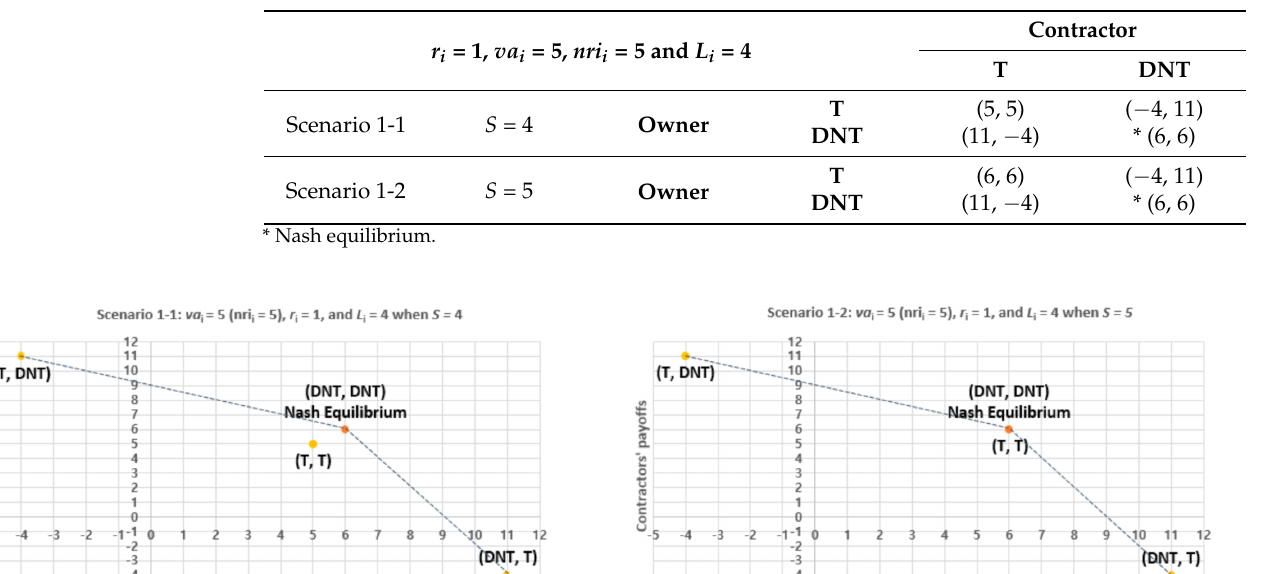
Table 6. Payoff matrix of Scenario 1.